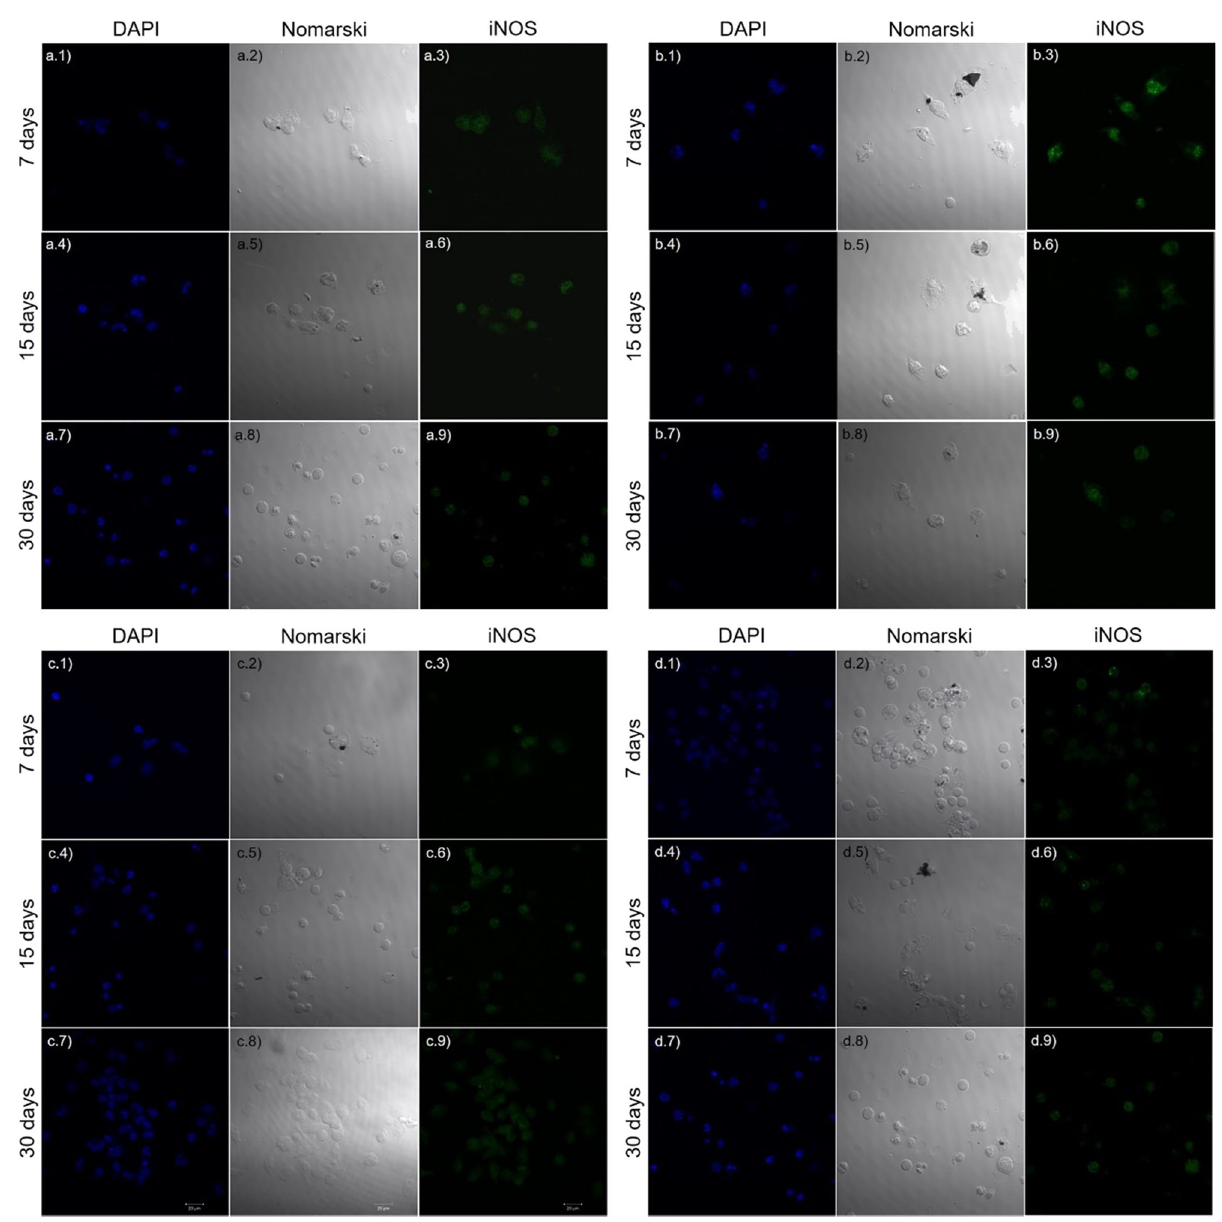
Fig. 4 Peritoneal macrophages of CF1 mice that received ( a ) stainless- steel, ( b ) DLC, ( c ) TiO 2 -DLC (0.1 g/L); and ( d ) TiO 2 -DLC (0.5 g/L) implants. The cells were cultured for 48 h on glass coverslips at 7, 15, and 30 days. Cell nuclei were stained with DAPI (blue), in the left